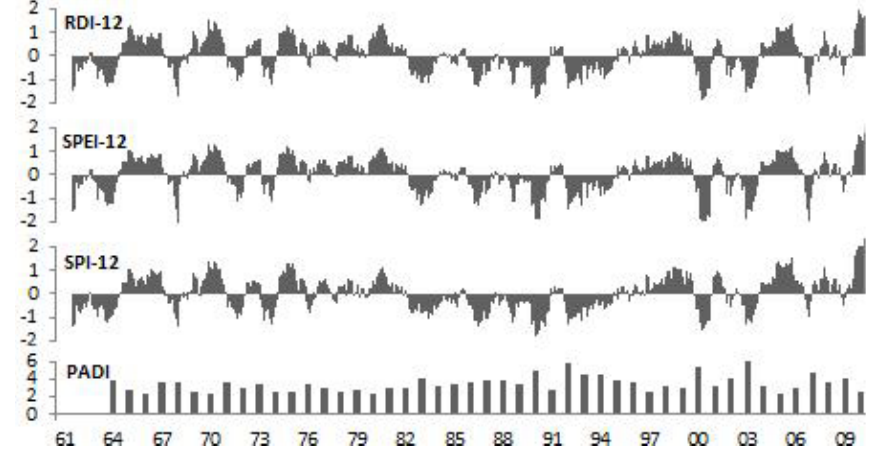
Figure 2. Monthly 1961-2010 drought series of RDI-12, SPEI-12, RDI-12, and annual 1964–2010 series of